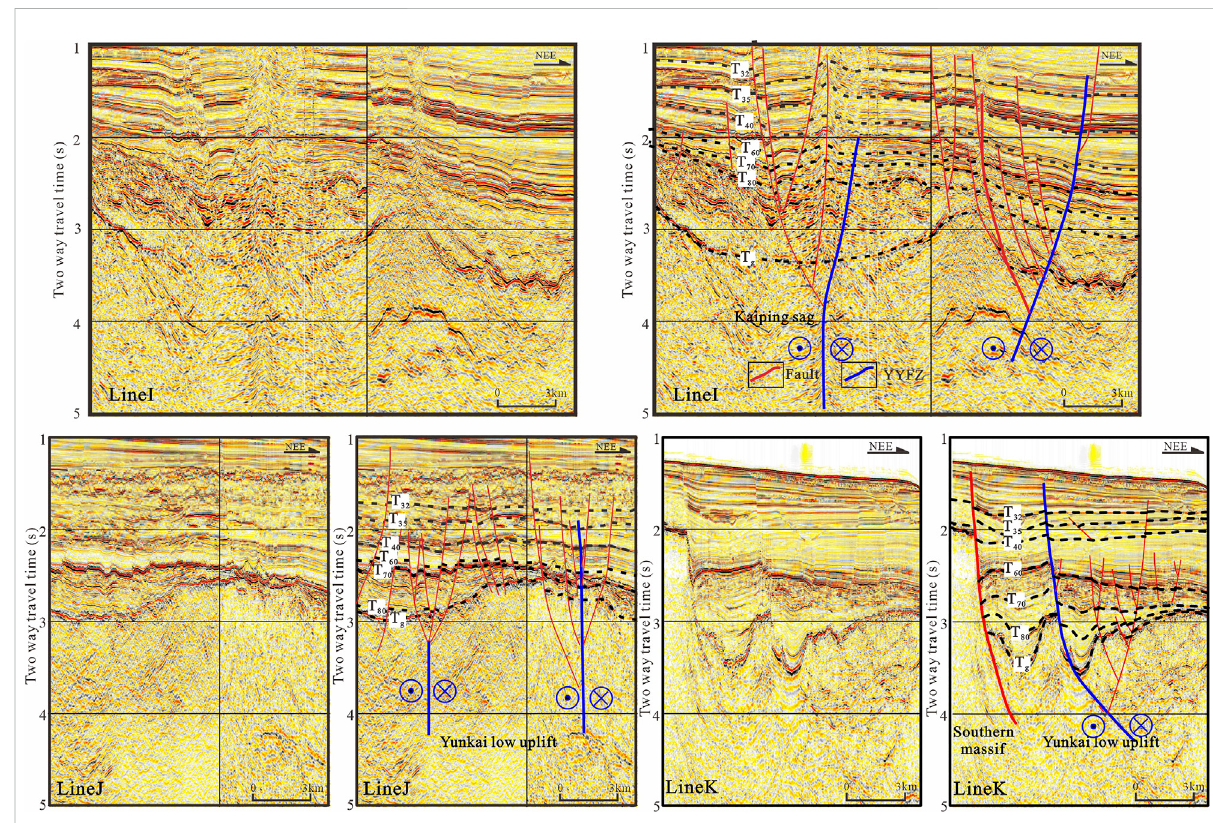
FIGURE 11 Seismic pro fi lesshowthegeometryoftheNW-trendingfaultsinthenorthernKaipingSagandYunkailowuplift.Thelocationofseismicpro fi les Line I and Line J-K are demonstrated in Figures 8, 9, respectively. These faults are characterized by fl ower or Y-shaped